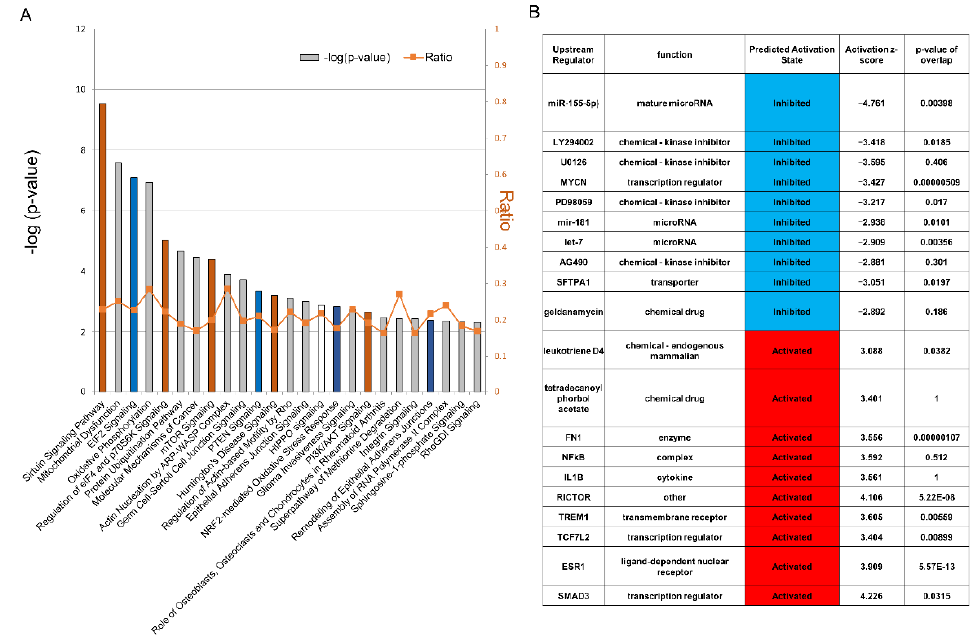
Figure 2. Gene expression (SMG vs. 1 G on day 1) by ingenuity pathway analysis (IPA) ( n = 3). ( A ) Significantly enriched canonical pathways identified by IPA. The diagram shows significantly overrepresented canonical pathways. A multiple-testing corrected p -value was calculated using the Benjamini–Hochberg method to control the rate of false discoveries in statistical hypothesis testing. The ratio represents the number of molecules in a given pathway that meet cut criteria, divided by the total number of molecules that belong to the function. ( B ) Upstream regulators of genes with altered expression under simulated microgravity (SMG). The top 10 upstream regulators that were repressed or activated are shown. Blue: repressed regulators; red: activated regulators.